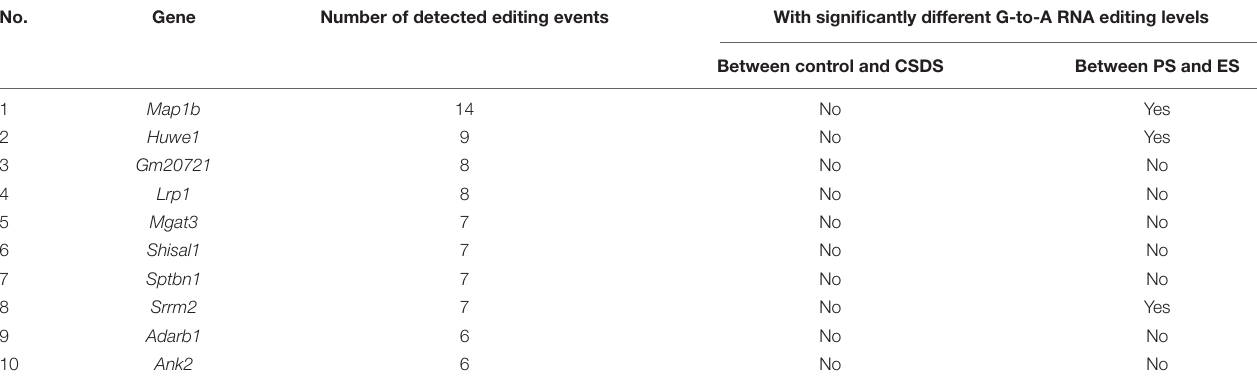
TABLE 1 | Top ten genes with the largest counts of G-to-A RNA editing events.